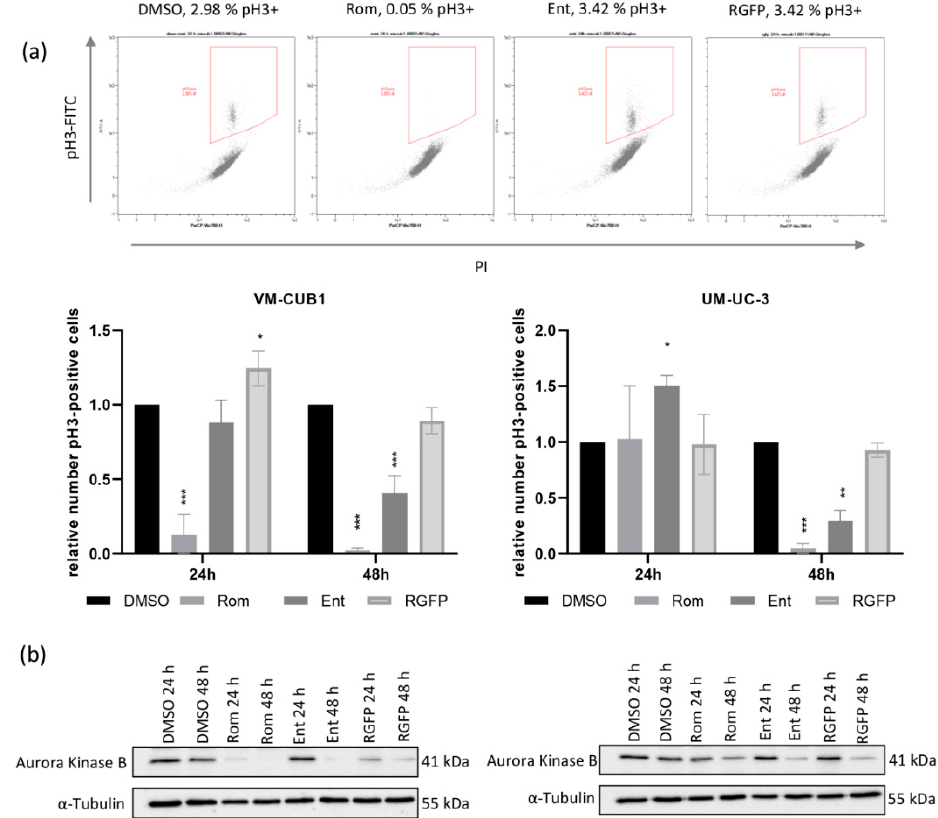
Figure 6. Phosphorylation of histone H3 is abolished by inhibition of HDAC1 and HDAC2 through Romidepsin treatment. ( a ) UC cells treated with indicated HDACi were stained for phosphorylated H3 and with PI and analyzed by flow cytometry after 24 h and 48 h. Cells double positive for PI and pH3 were gated as cells in M phase. Example raw data of one representative experiment for VM-CUB1 24 h after indicated treatment is visualized. Numbers of cells positively stained for phosphorylated H3 (pH3+) are given above the plots. Further example raw data is shown enlarged in Figures S3 and S4. Means of independent experiments are displayed in bar graphs. Relative number of double positive cells after normalization to DMSO controls is given. *** p ≤ 0.001, ** p ≤ 0.01, * p ≤ 0.05. ( b ) Protein expression of AURKB was determined by western blot analysis in VM-CUB1 and UM-UC-3 cells 24 h and 48 h after treatment with the indicated HDACi. α -Tubulin was stained as a loading